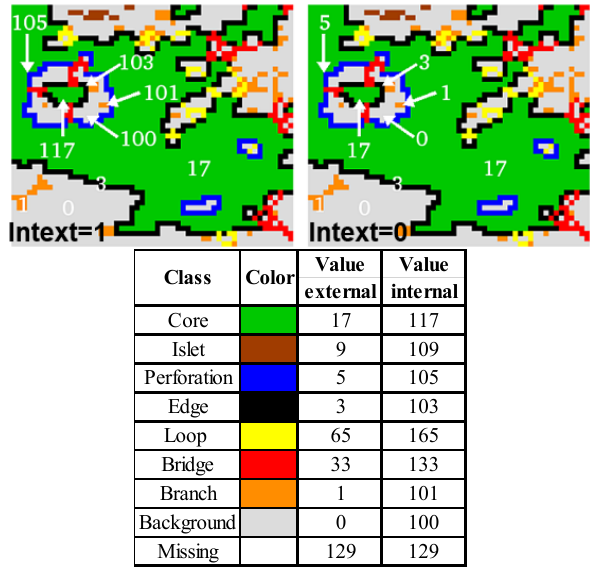
Figure 2. Illustration of the fragmentation classes that are generated when setting the intext parameter to on (value of 1) or off (value of 0) for a hypothetical area and foreground (forest) patches. Cells in grey color represent the background (non ‐ forest) areas. The numbers correspond to the values assigned to each fragmentation class as unique identifiers [47].